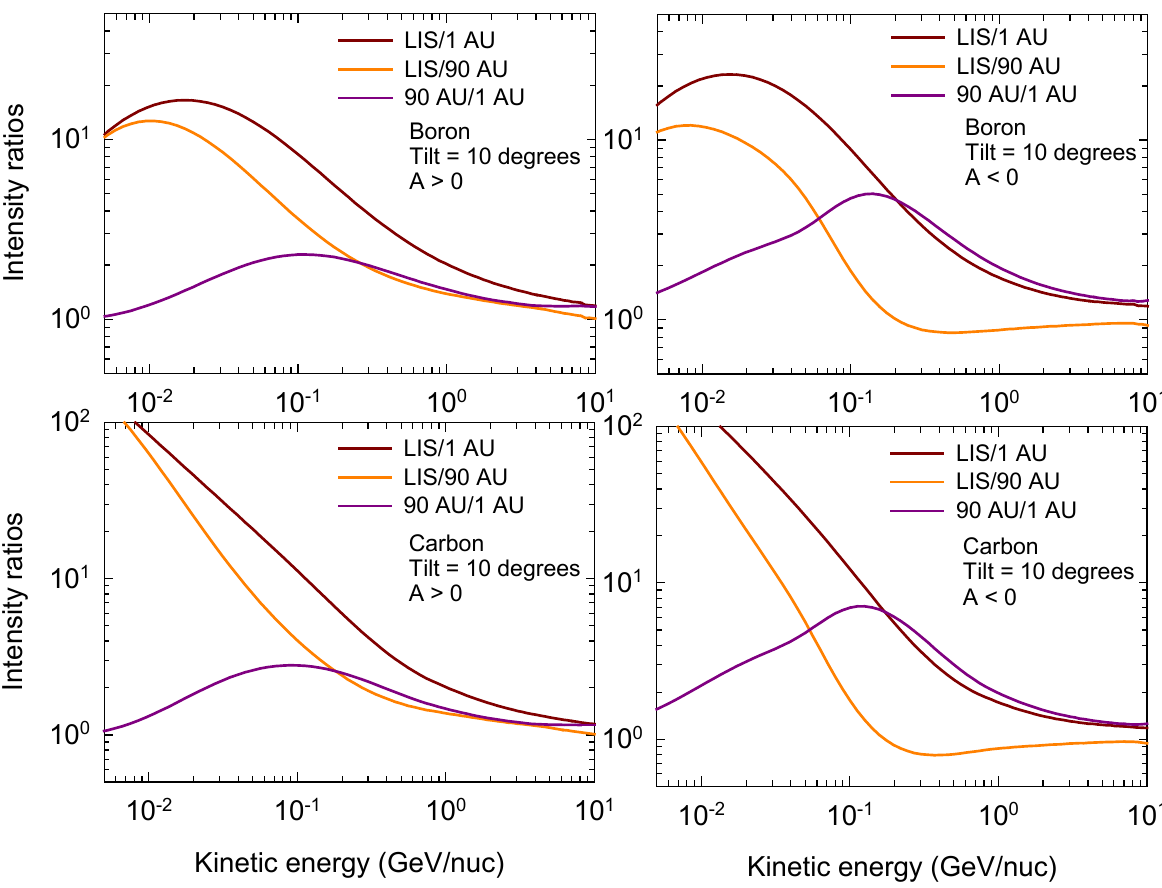
Fig. 5 . Intensity ratios j /j , j /j and j /j ( 120 to 1 AU, 120 to 90 AU and 90 to 1 AU) for B and Fig. 5. Intensity ratios j LIS / j 1 , j LIS / j 90 and j 90 / j 1 (120 to 1AU, 120 to 90AU and 90 to 1AU) for B and C as a function of kinetic energy LIS 1 LIS 90 90 1 in the equatorial plane with α =10 ◦ ; left panels: for A> 0, right panels for A< 0. Interstellar spectra are considered local interstellar spectra C as a function of kinetic energy in the equatorial plane with α = 10 ° ; left panels: for A > 0, right (LIS) at 120AU and the TS is positioned at 90AU. Note the scale difference between some of the panels for A < 0. Interstellar spectra are considered local interstellar spectra (LIS) at 120 AU and the TS is positioned at 90 AU. Note the scale difference between some of the panels.